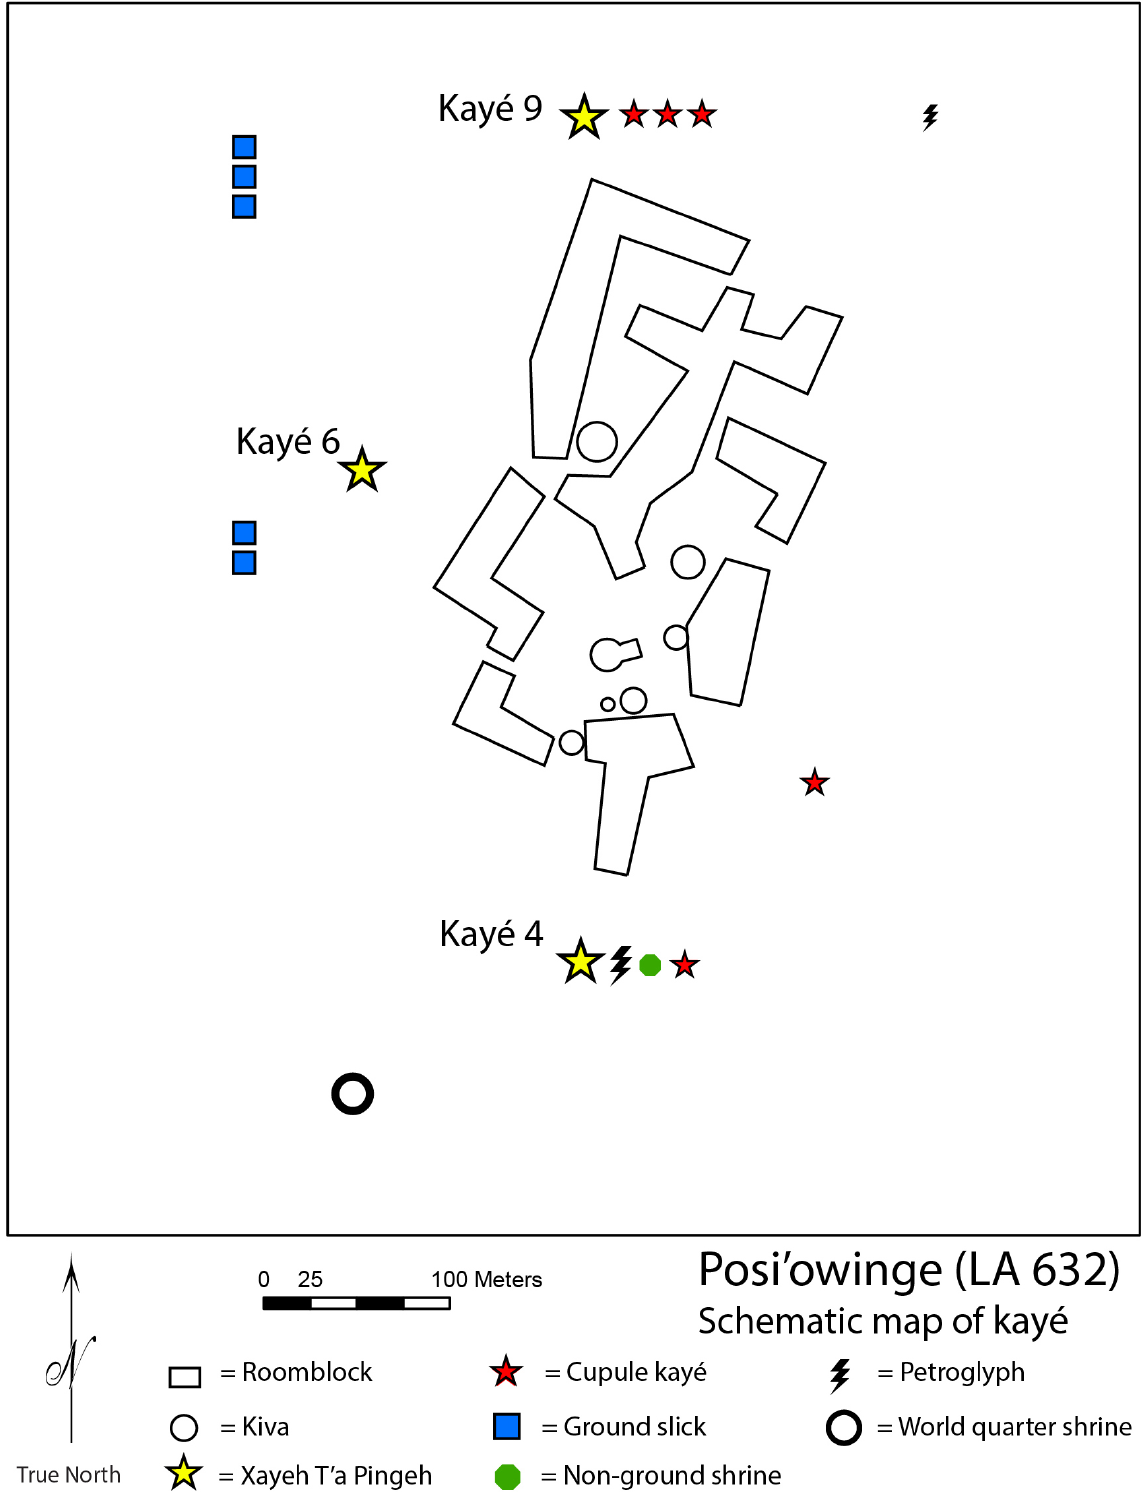
Figure 8. Kayé and Xayeh T’a Pingeh with cupules, and associated landscape features, at the Classic period site of Posi’owingeh. [NOTE (23 JUNE 2017): This figure has been modified at the request of the